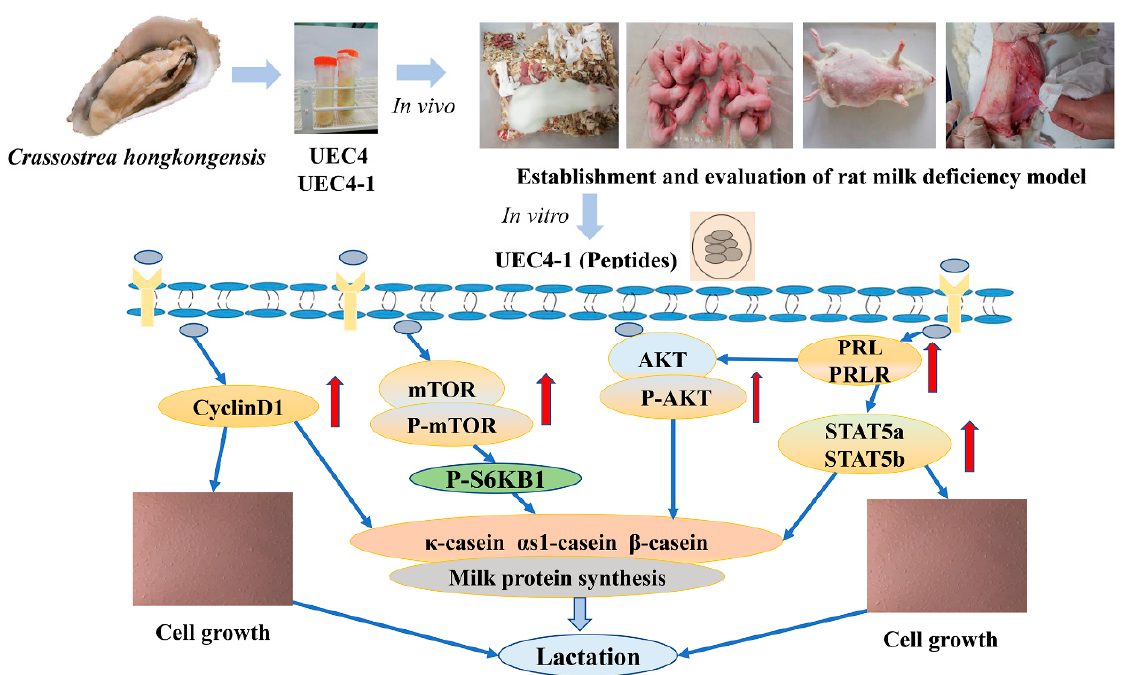
Figure 11. Possible mechanism of UEC4-1.